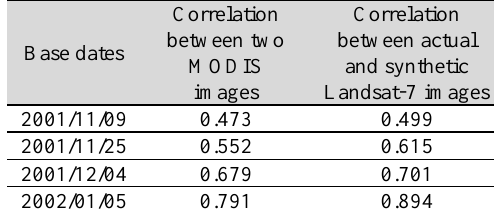
Table 2. Relationship between MODIS images of the base and prediction dates in the CIA site, and its corresponding correlation between actual and synthetic Landsat-7 images. The example is for the red spectral band in January 11, 2002 (i.e.,